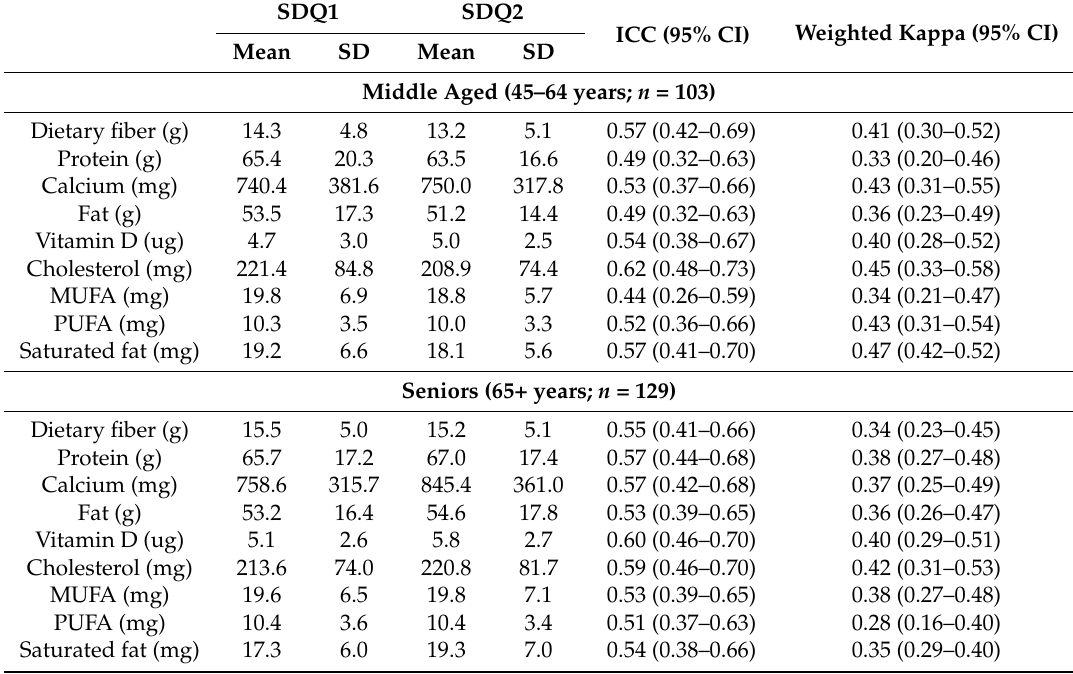
Table 2. Estimated intakes of nutrients of interest from SDQ1 and SDQ2 and test-retest reliability between administrations, CLSA Diet Study ( n = 232).